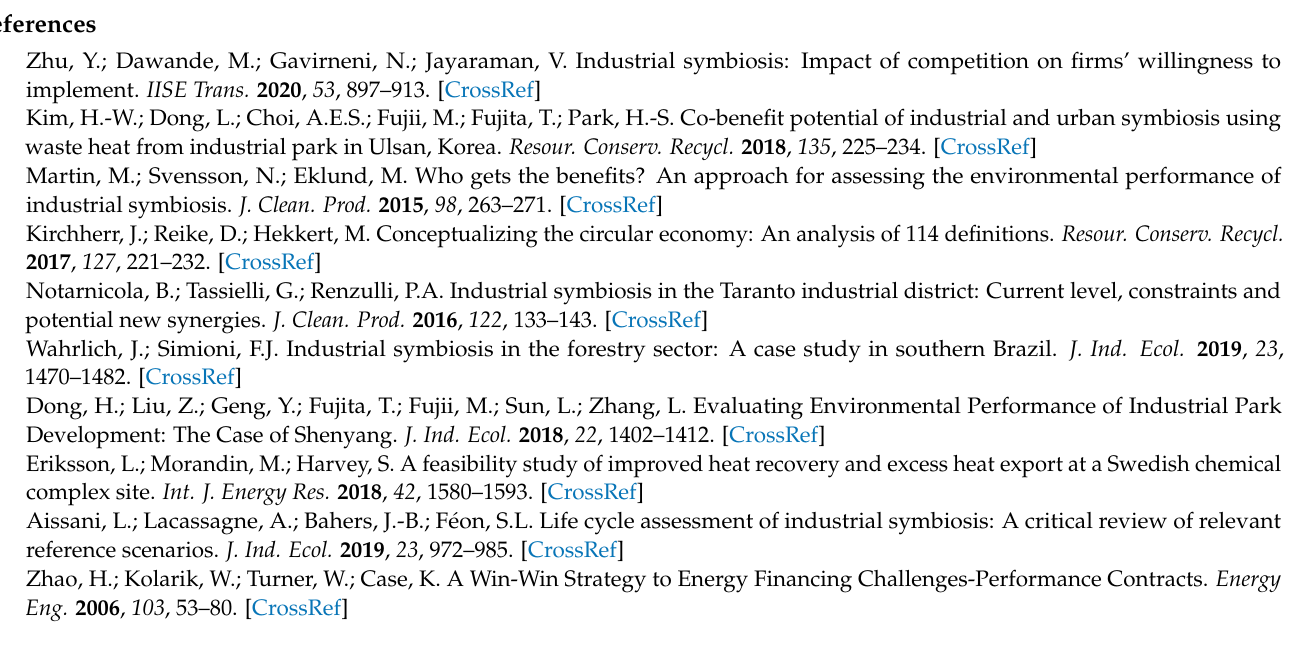
Figure A1. The process simulation model that was built do describe the energy cooperation in Sundsvall. Steam and hot water are exchanged between he different actors.